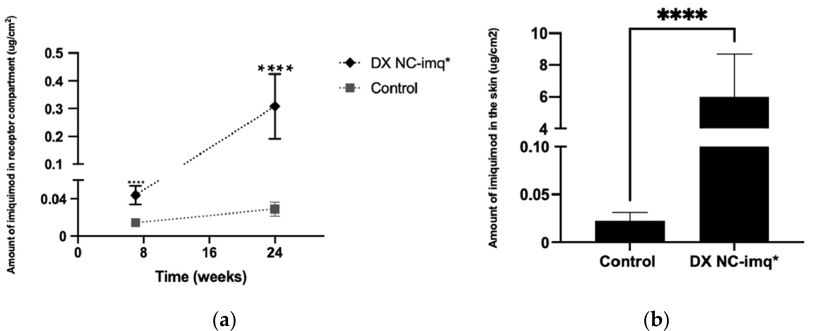
Figure 10. Studies of transdermal permeation and retention of imiquimod in the designed nanosystem. ( a ) Transdermal penetration of imiquimod carried in DX NC-imq*. ( b ) Imiquimod skin retention at the end of the transdermal studies. DX NC-imq*: dextran nanocapsules with imiquimod in their core. * Formulation elaborated applying high manual pressure. (Mean ± SD, n = 6). **** Statistically significant ( p < 0.01).